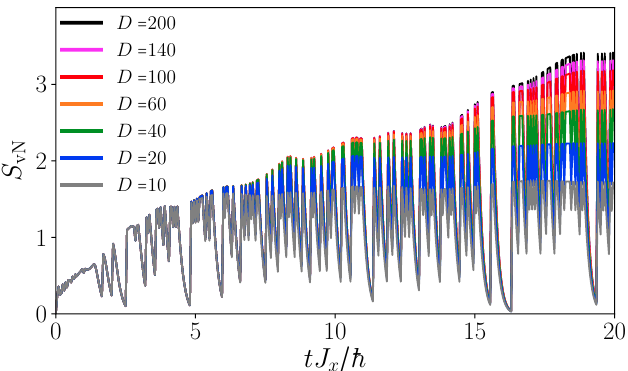
Figure 6: Evolution of the von Neumann entropy S with different maximal values for the bond dimension for a chain of length L = 32, dissipation strength (cid:126) γ/ J and truncation goal (cid:34) = 10 − 12